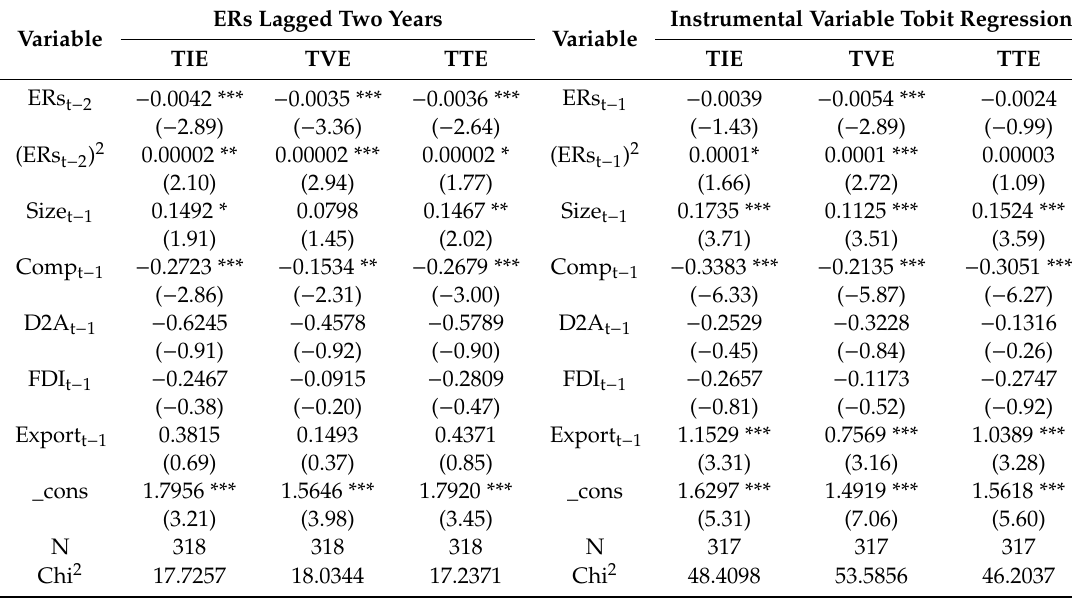
Table 7. Regression results of robustness